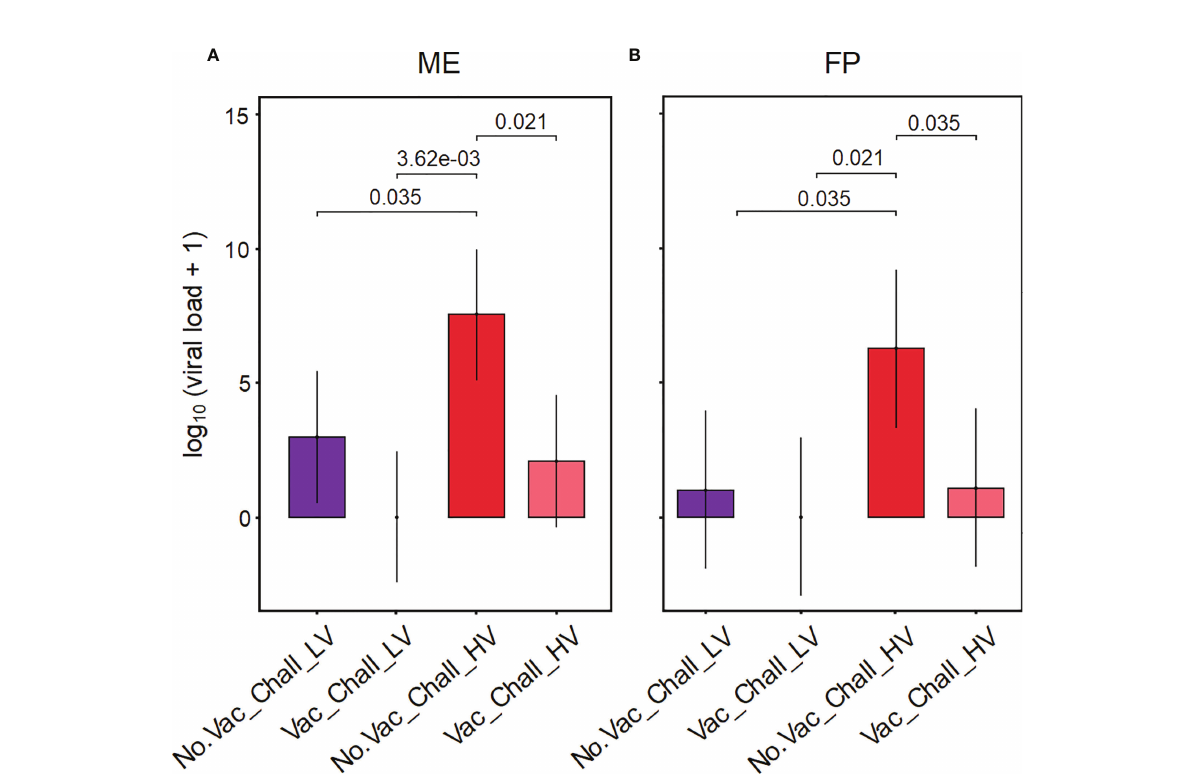
FIGURE 1 Viral RNA at the maternal-fetal interface of infected and vaccinated-infected gilts. Porcine reproductive and respiratory syndrome virus (PRRSV) RNA was extracted from tissue from the maternal endometrium (ME) and fetal placenta (FP). The viral load within the respective tissues was determined using an ORF7 PRRSV-1 fi eld isolate speci fi c RT-qPCR. PRRSV RNA was not detected in tissue samples from the No.Vac_No.Chall and Vac_No.Chall group and are therefore not shown. A linear mixed effects model fi tting a fi xed categorical effect (treatment) and